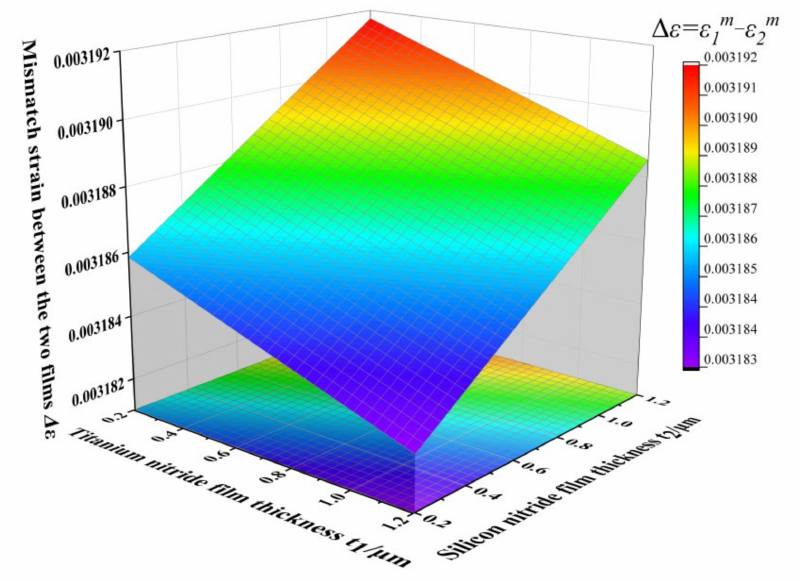
Figure 4. TiN/Si 3 N 4 film thickness and interlayer mismatch strain ∆ ε